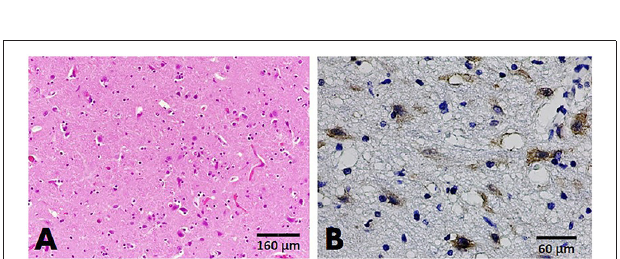
FIGURE 5 | Brain, cat no. B135. (A) HandE staining showing mild satellitosis in the gray matter of the brain stem. (B) IHC slides showing positive immunoreactivity to the FCV antigen in small neurons comprising the cerebral